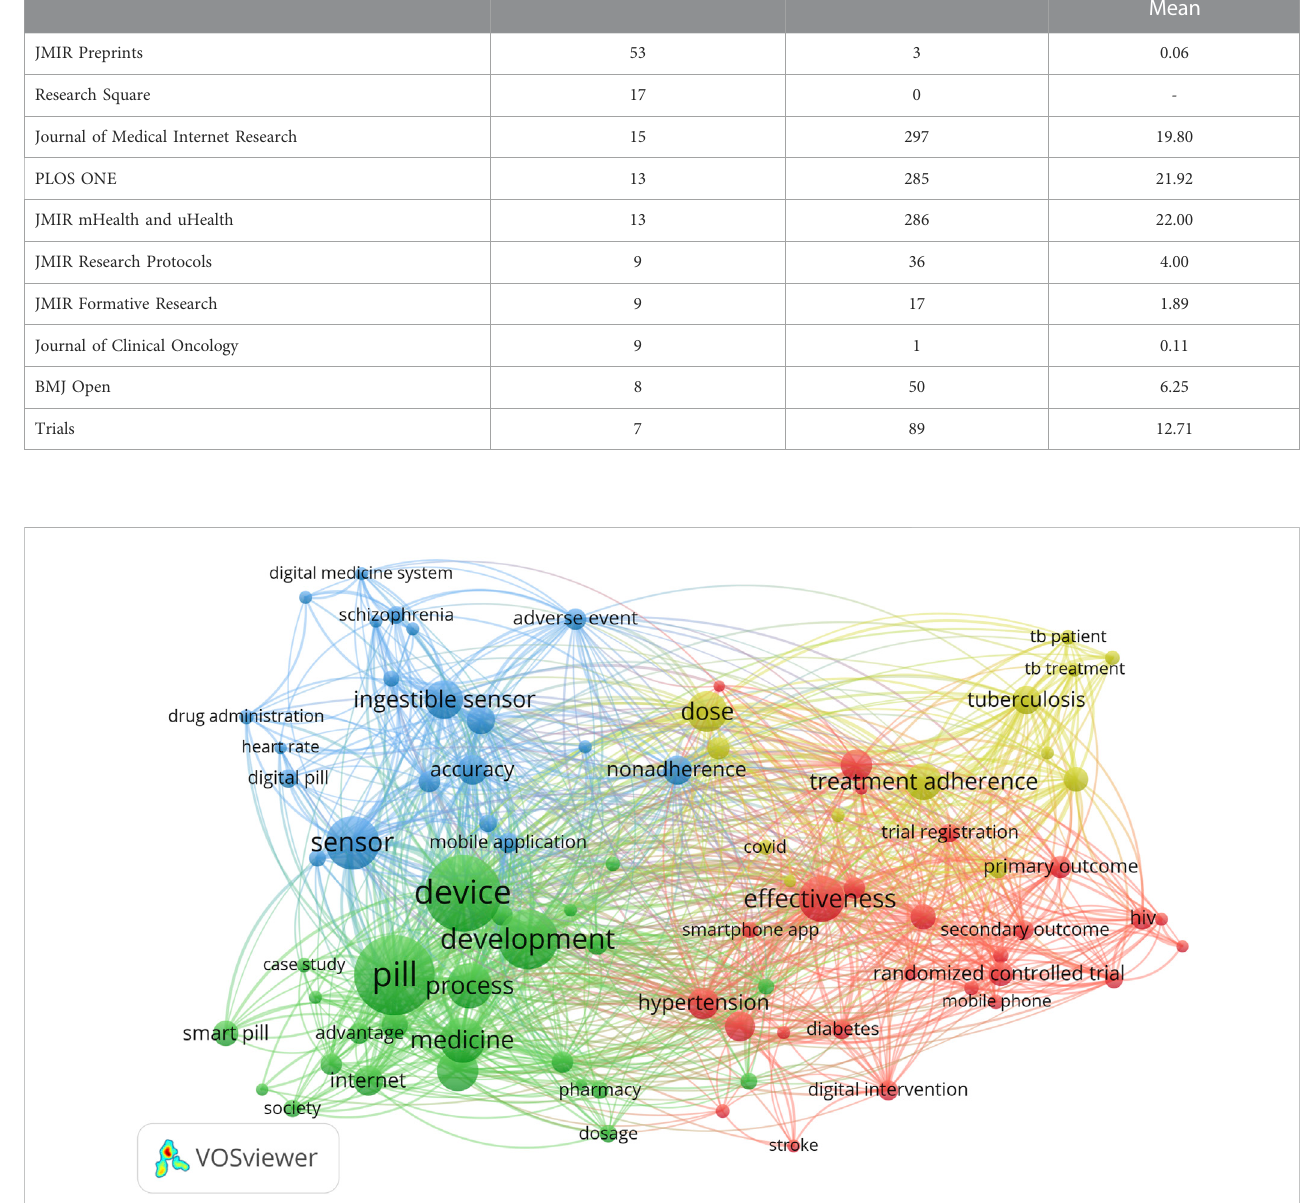
FIGURE 3 The terminological map of publications in the fi eld of development and research of digital pills for the period January 2012 to July